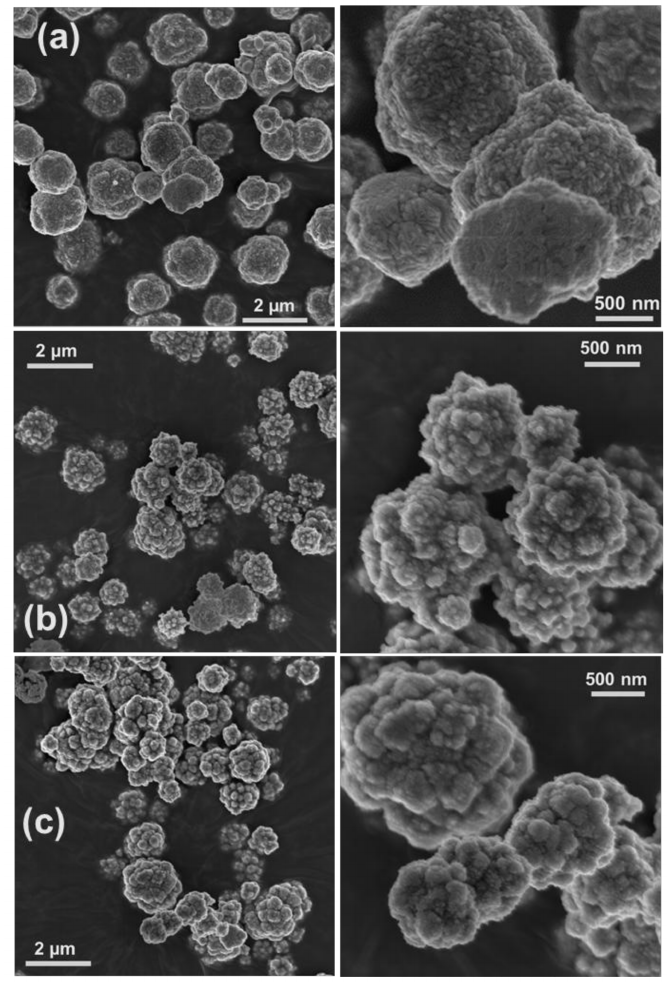
Figure 1. HR-SEM images of materials obtained in 0.01 M Cu(II) solutions containing ( a ) 0.01 M EDTA, ( b ) 0.01 M DTPA, and ( c ) 0.01 M C 12 -DTPA. The images show the polycrystalline structure of spherical copper particles of 1–1.5 µ m, synthesized in solution ( a ) and copper particles of 800 nm–1.2 µ m, formed in solutions ( b ) and ( c ). The images on the right-hand side are of synthesized materials ( a – c ) at higher